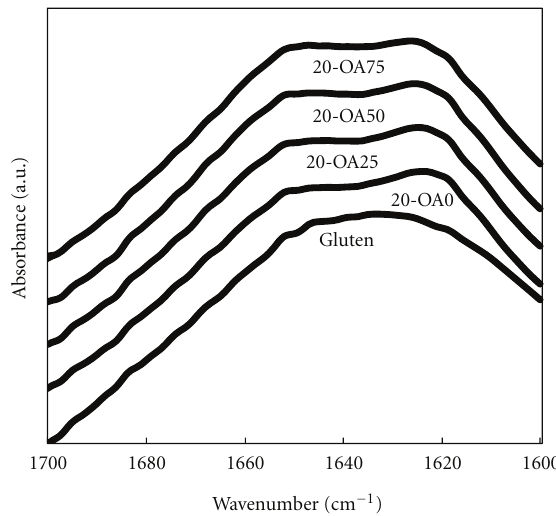
Figure 4: IR spectra for the samples containing 20 wt.% plasticizer in the amide I region. Sample notation: wt.% plasticizer-OA (wt.% oleic acid in the plasticizer mixture). For clarity the curves have been shifted vertically. Gluten refers to unprocessed wheat gluten.